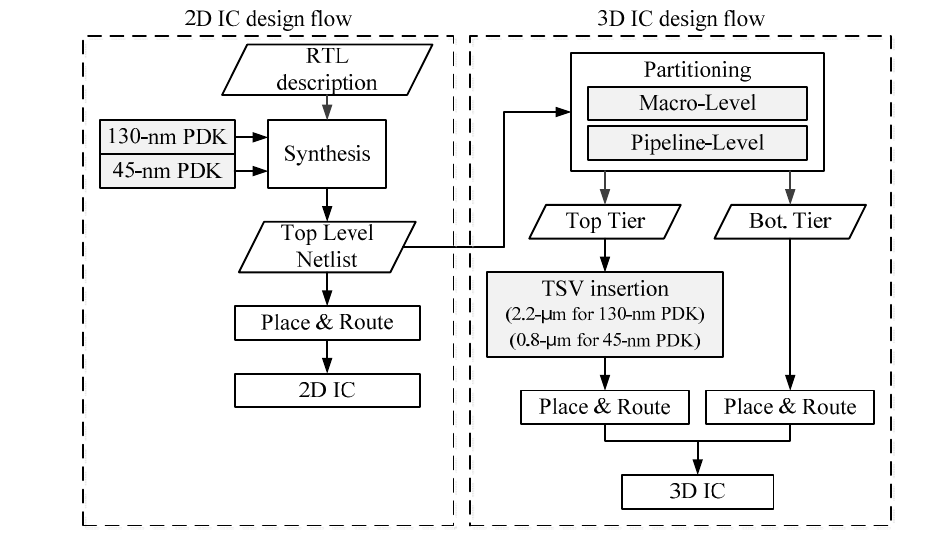
Figure 6. 2D and 3D IC design flow. Table 3. Summary of synthesis results.